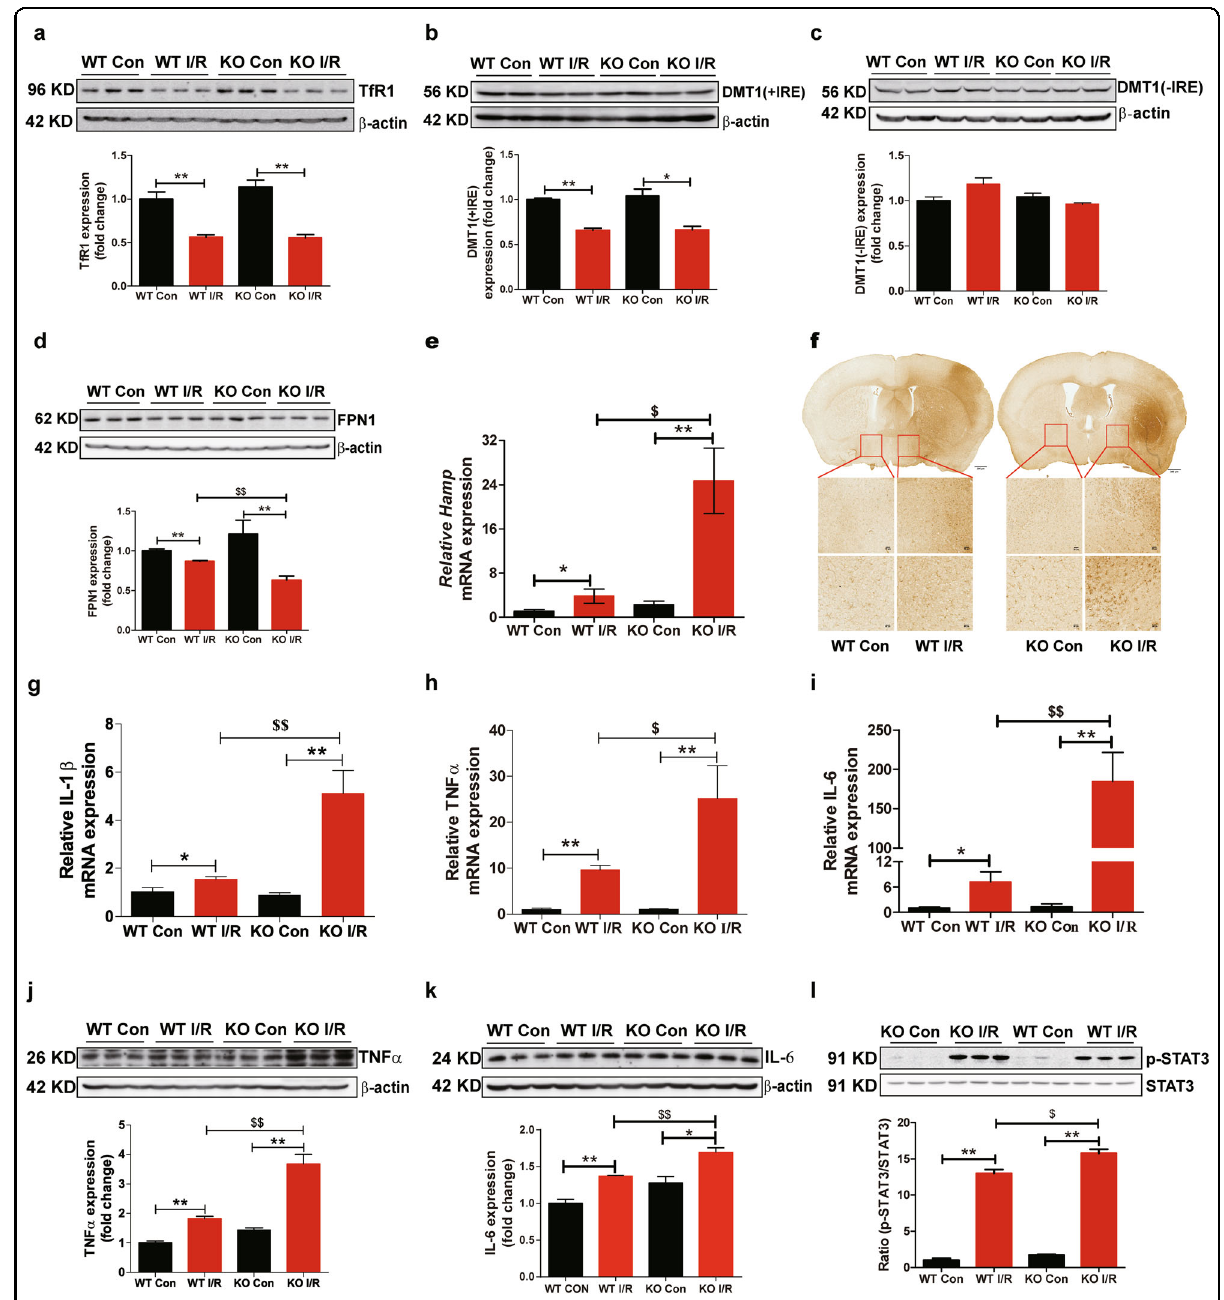
Fig. 6 FtMt ablation promotes hepcidin expression and FPN1 degradation in I/R. Western blot analysis of the iron uptake proteins ( a ) TfR1, ( b ) DMT1( + IRE), and ( c ) DMT1(-IRE) and the iron export protein ( d ) FPN1 in wild-type (WT) and Ftmt -knockout mice ( n = 5). e The relative mRNA expression of hepcidin ( Hamp ) was measured in the control (Con) and I/R groups. The mRNA levels were normalized to β -actin mRNA levels and are expressed relative to the mean value in the WT Con group ( n = 6). f Brain sections derived from WT and Ftmt- knockout mice after cerebral I/R were immunostained for Iba-1 to assess the activation of microglia. The relative mRNA levels of ( g ) IL-1 β , ( h ) TNF α and ( i ) IL-6 were measured in the Con and I/R sides of mouse brains. The mRNA levels were normalized to β -actin mRNA levels and are expressed relative to the mean value in the WT Con group ( n = 5). The expression of ( j ) TNF α , ( n = 5) ( k ) IL-6, ( n = 5) ( l ) p-STAT3 and STAT3 ( n = 6) was assessed by Western blot analysis. The results are presented as the mean ± SEM. * /$ P < 0.05, ** /$$ P <